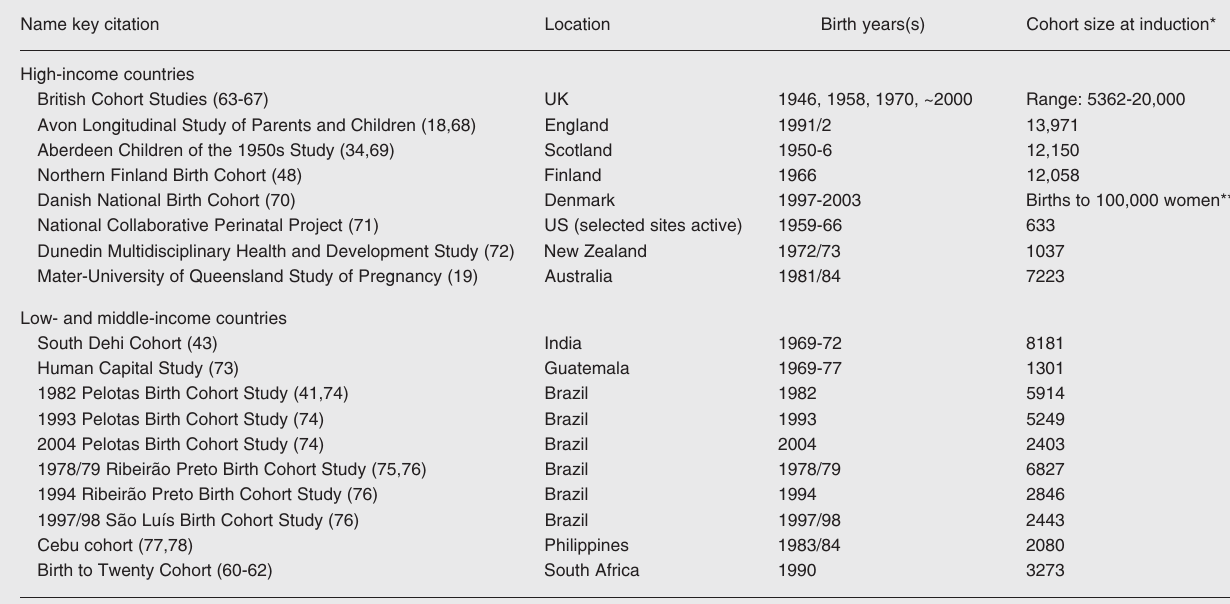
Table 1. Birth cohort studies from economically developed and developing